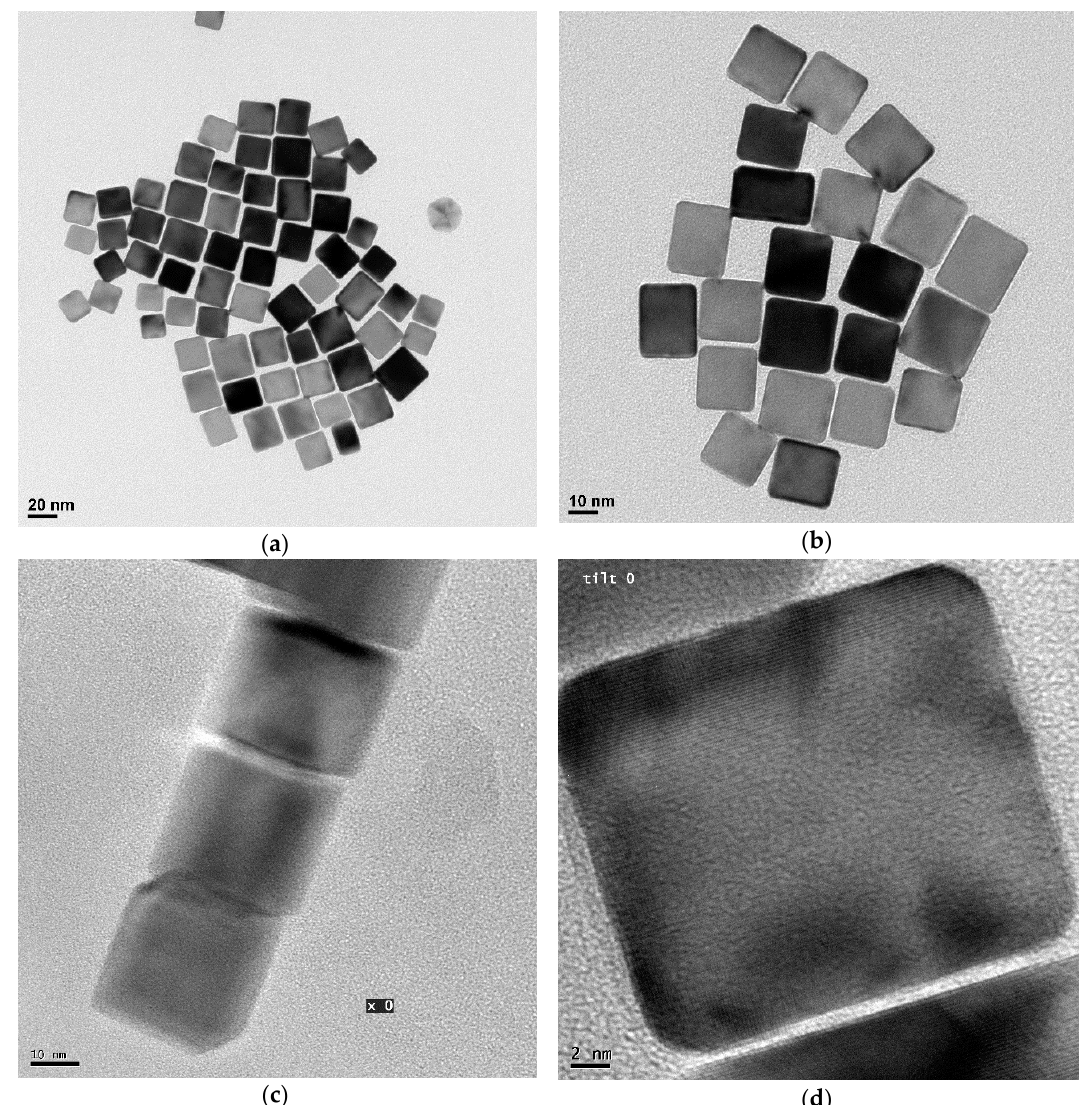
Figure 1. Transmission Electron Microscopy (TEM) images of the Pd nanocubes (see Supporting Information in [23]) From ( a ) to ( d ) progressive magnification to the nanoparticles. Image ( a ) and ( b ) show the limited size dispersion and an example in ( a ) of the non-crystallographic fraction (the multiply-twinned particle on the right of the image). In ( c ) and ( d ) a magnification of a single nanoparticle, showing details of the truncated cube shape. (Images adapted from [23], with permission from iucr journals , 2019).